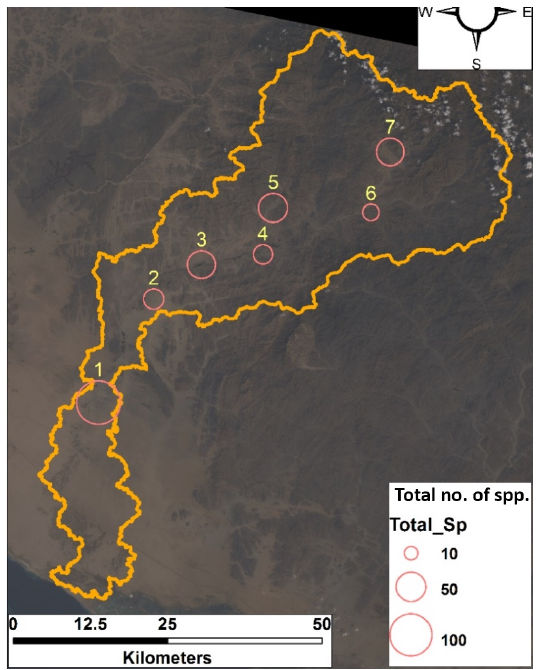
Figure 2. The total number of species in Wadi